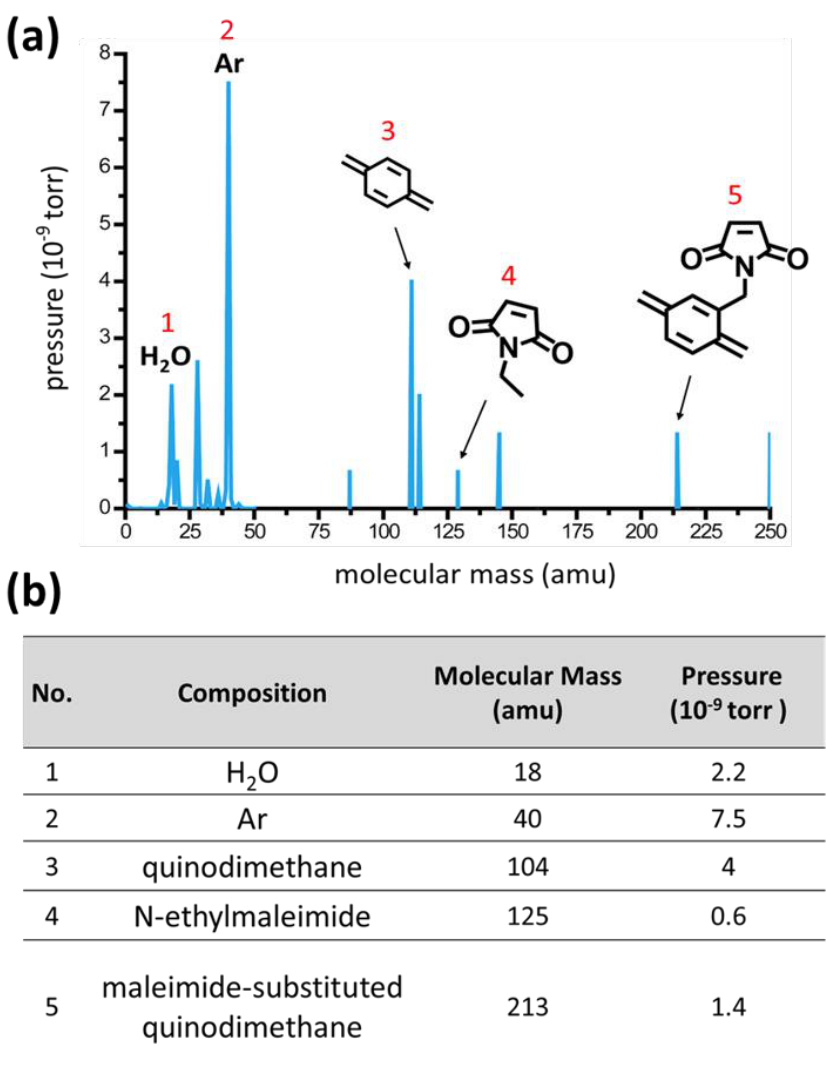
Figure 2. The characterizations of the vapor compositions, based on mass spectrometric analysis using a (residual gas analyzer) RGA during the fabrication process. The recorded mass spectra in ( a ) show the presence of 5 expected molecules: (1) the sublimating water molecules at 18 amu, (2) the carrier gas of argon at 40 amu, (3) the depositing quinodimethane at 104 amu, (4) a fraction of N-ethylmaleimide at 125 amu, and (5) the maleimide-substituted quinodimethane at 213 amu. ( b ) A table summarizing the details of the detected molecules in the vapor compositions.